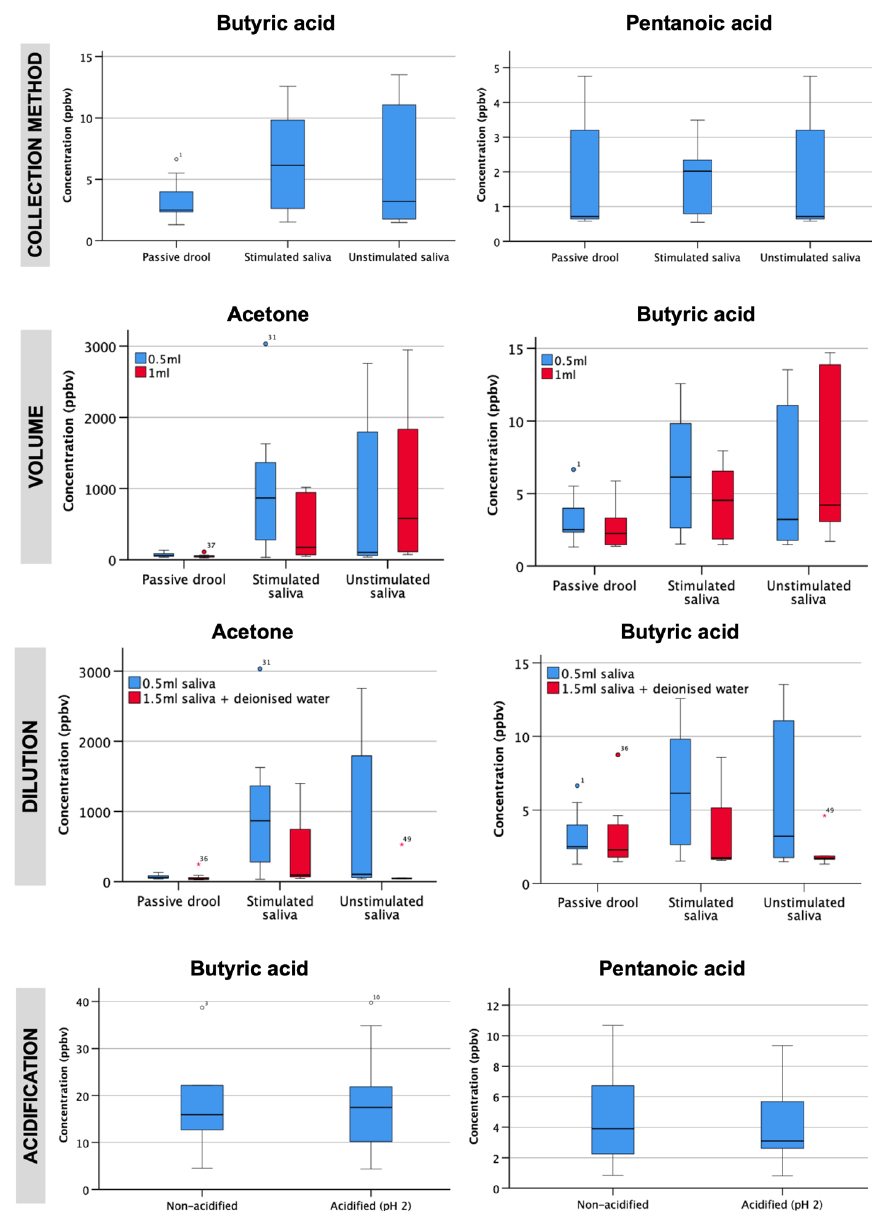
Figure 1. Four methodological parameters of saliva headspace optimised by VOC concentration (ppbv) assessment. Circles and asterisks denote outlying